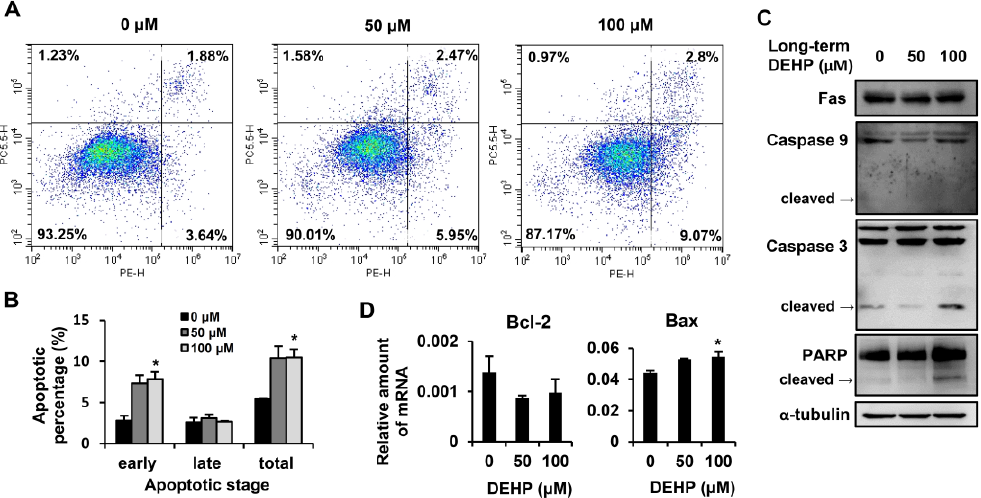
Figure 5. Effects of long-term, low-dose DEHP exposure-induced apoptosis in HSC-T6 cells. (A) Apoptosis detected by the Phycoerythrin (PE) Annexin V Apoptosis Detection Kit I and detected by the Phycoerythrin (PE) Annexin V Apoptosis Detection Kit I and representative images representative images are shown. Quantitative data are shown in (B) . (C) Western blot analysis of Fas, Caspase 9, Caspase 3, PARP, and α -tubulin in long-term, low-dose, DEHP-exposed HSC-T6 cells. (D) Q-PCR analysis of Bcl-2 and Bax in long-term, low-dose, DEHP-exposed HSC-T6 cells. * p < 0.05 vs. 0 µM.